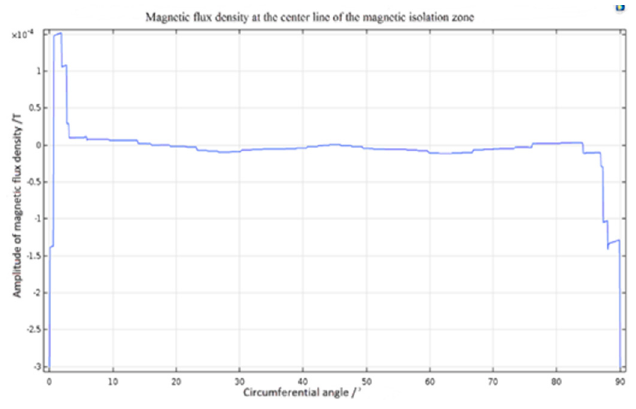
Figure 5. Magnetic flux density at the center line of the magnetic isolation zone.